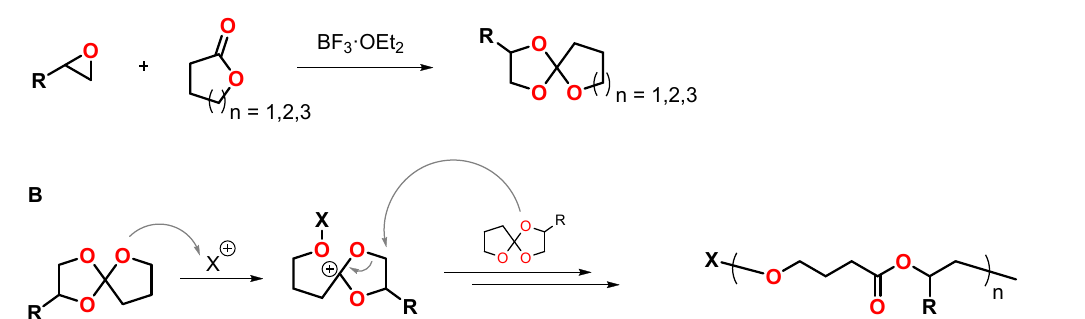
Figure 10. A : Synthesis of SOEs from epoxides and lactones. B : Schematic representation of the cationic double ring-open- Figure 10. (A ): Synthesis of SOEs from epoxides and lactones. ( B ): Schematic representation of the cationic double ing polymerization of SOEs. ring-opening polymerization of